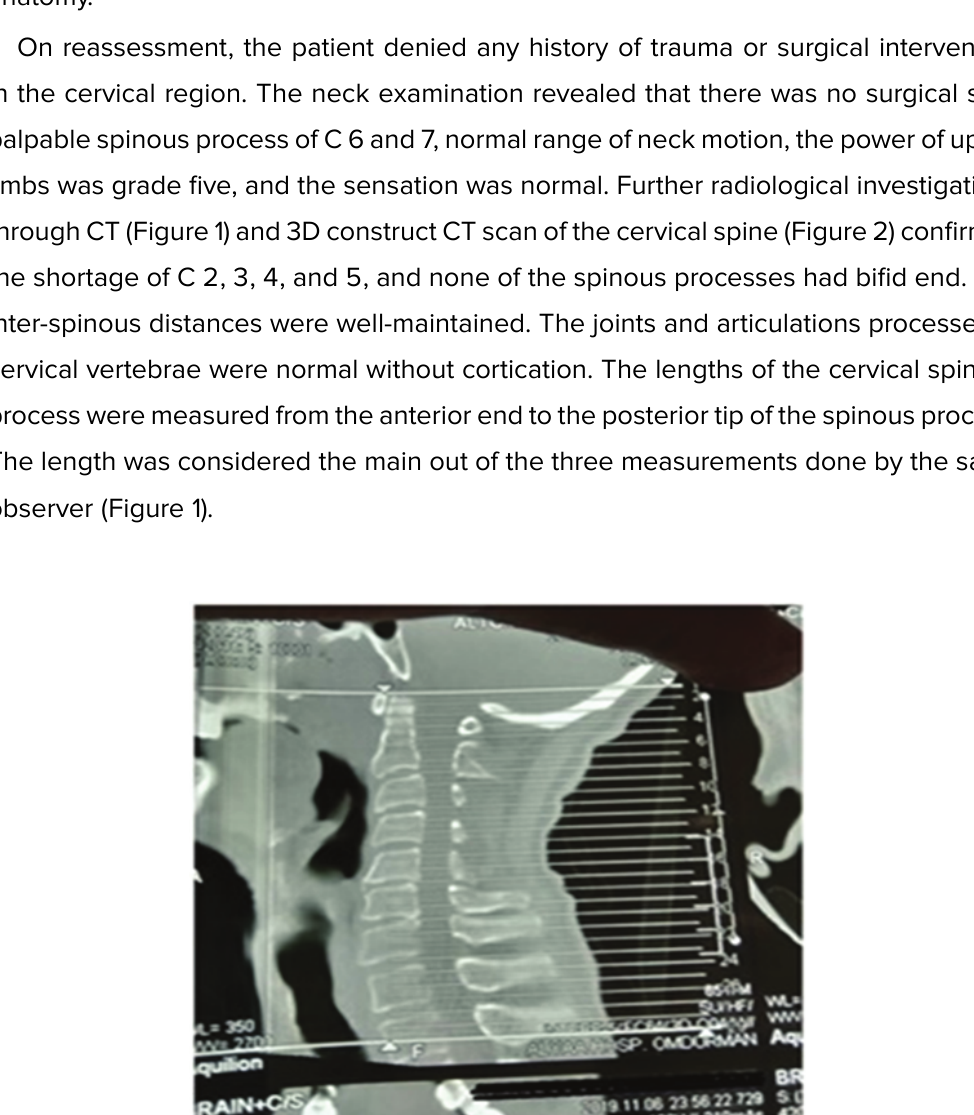
DOI 10.18502/sjms.v17i2.11458